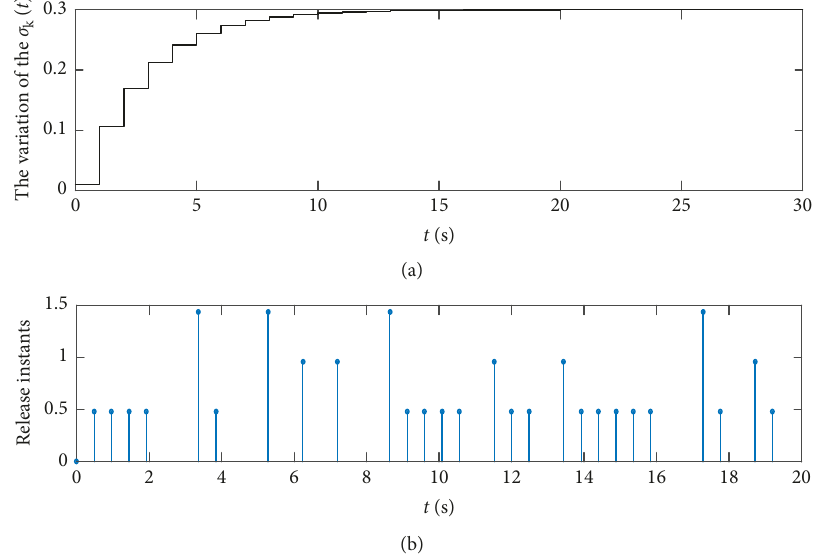
Figure 2: The parameter σ